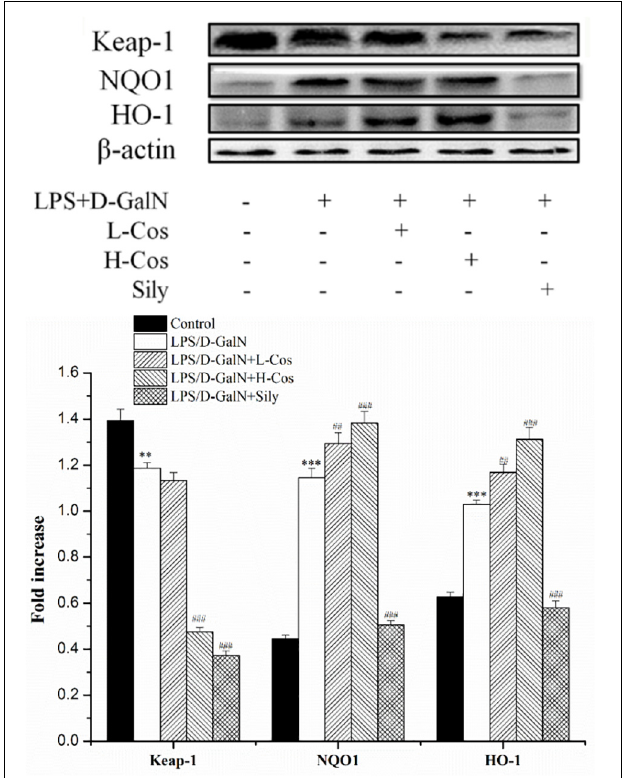
FIGURE 9 | Effects of cos on the expression of proteins related to Keap-1 signaling pathway. The expression of hepatocyte oxidative stress related proteins Keap-1, HO-1, NQO1 were analyzed by western blot. The data represented as mean ± SD ( n = 10). ∗∗ P < 0.01, ∗∗∗ P < 0.001 vs. control group; ## P < 0.01 and ### P < 0.001 vs. LPS/ D -GalN